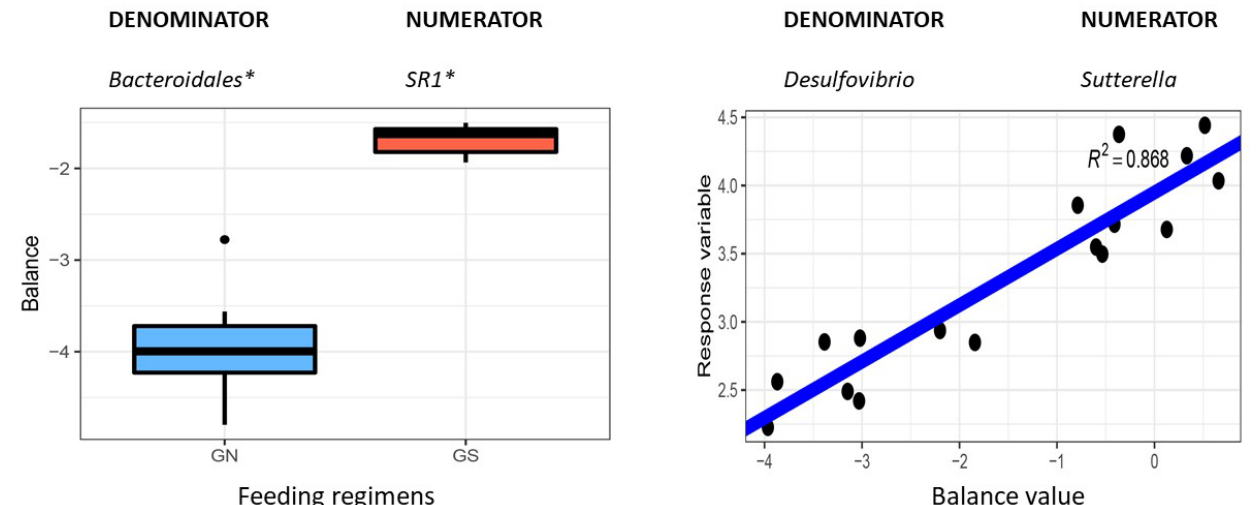
Figure 8. Rumen microbial signatures selected by the selbal algorithm with a strong predictive accuracy. ( A ): The microbial predictor accurately distinguished the grass and grain feeding